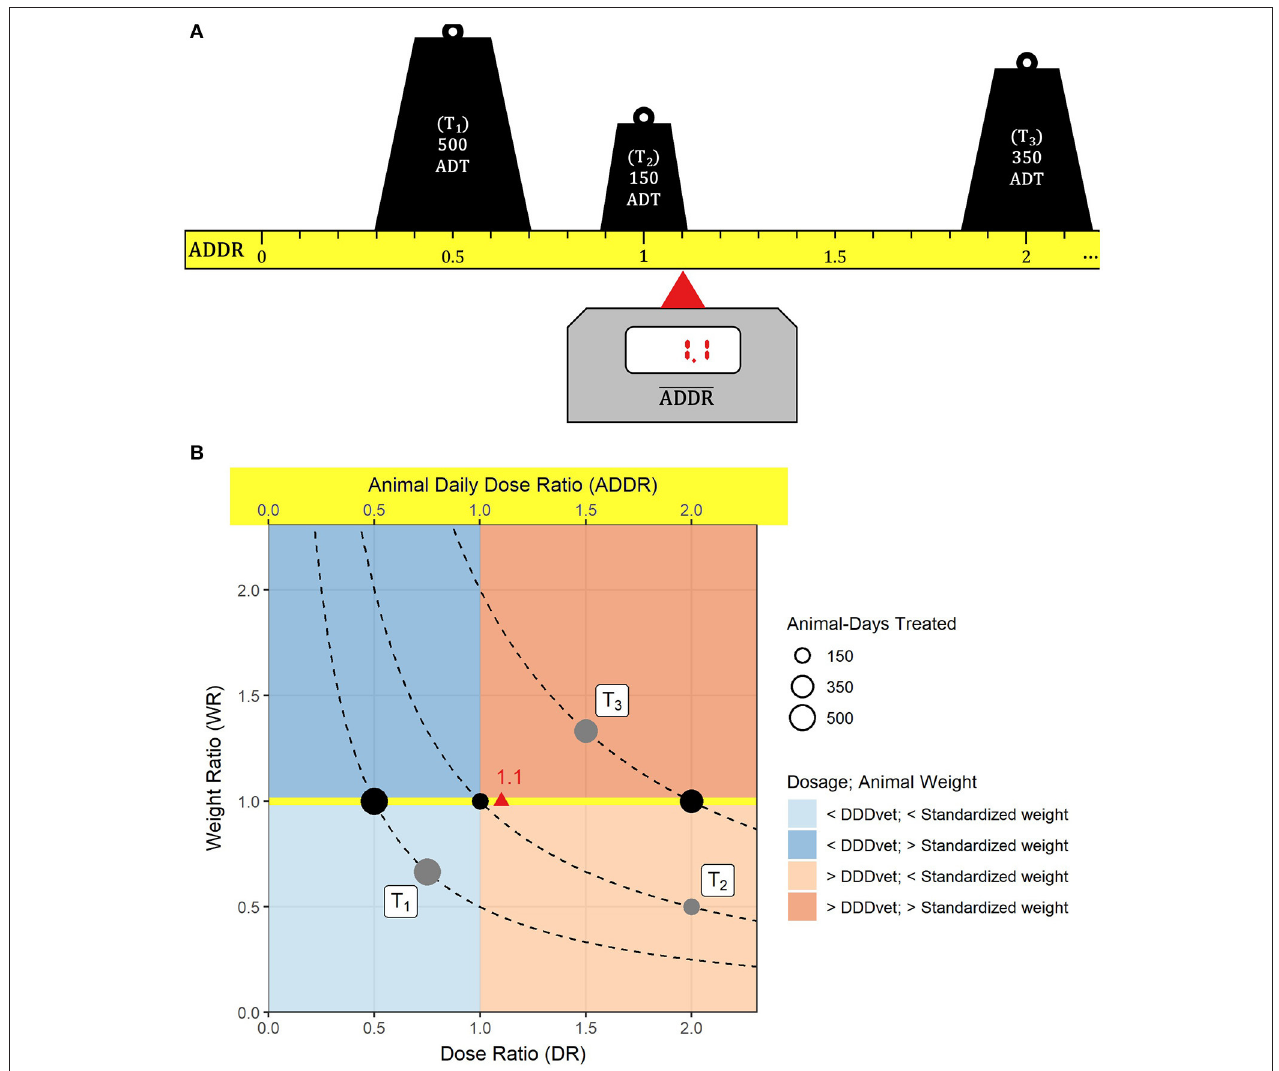
FIGURE 1 | An example illustrating the average animal daily dose ratio. Three treatments take place on a farm: (T 1 ) 500 animal-days treated (ADT) with an animal daily dose ratio (ADDR) of 0.5, (T 2 ) ADT = 150, ADDR = 1 and (T 3 ) ADT = 350, ADDR = 2. (A) Each treatment is represented by a weight according to the number of animal-days treated that is located on a ruler measuring the animal daily dose ratio on a linear scale (the ruler is assumed to be weightless and may extend further to the right if necessary). The average animal daily dose ratio (ADDR = 1.1) marks the point of support on the ruler where the setup balances out. (B) The treatments are shown as gray circles on a Cartesian plane where the abscissa of the circle’s center is the dose ratio, its ordinate is the weight ratio, and where the area of the circle represents the number of animal-days treated. Each treatment is located on a hyperbole (dashed curves) along which the ADDR is constant. Therefore, in terms of the animal daily dose ratio the black circles are equivalent to the original treatments T 1 , T 2 , and T 3 . They are located on a yellow strip that is equivalent to the ADDR ruler in (A) and whose values can be read off the upper abscissa. The red triangle marks the ADDR